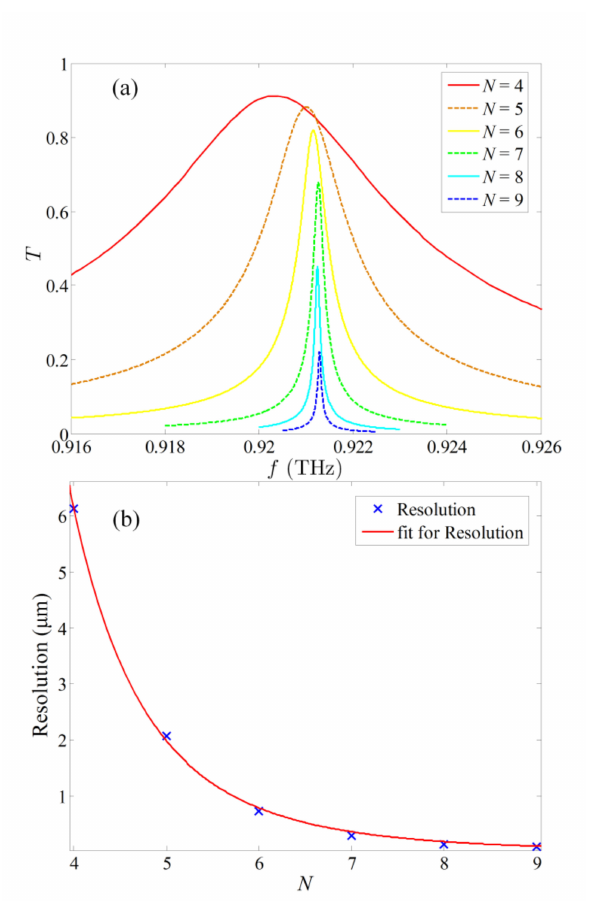
Figure 5. Transmitted peaks ( a ) and measurement resolutions ( b ) for di ff erent numbers of